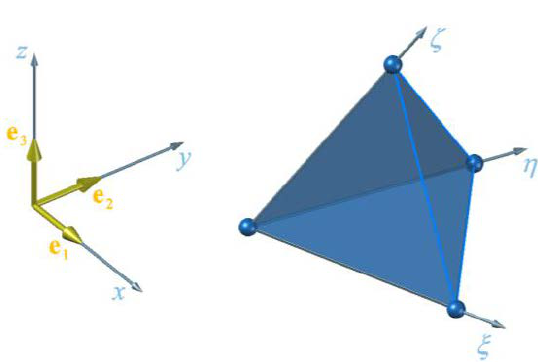
Figure 41: Local reference system of the aflne coordinates for a 3-symplex (tetrahedron).